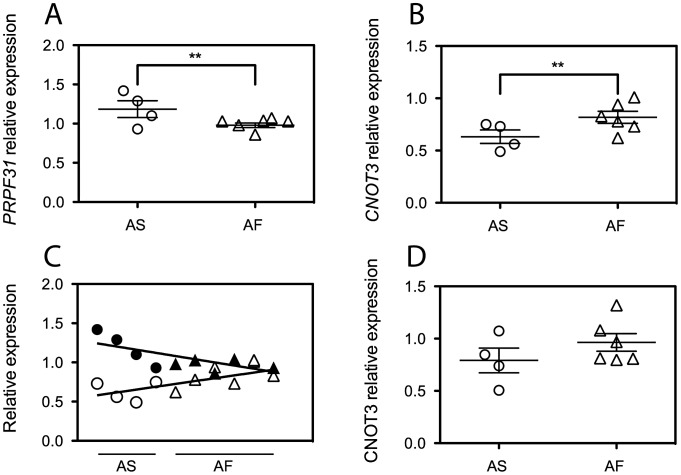

CNOT3 shows an opposite trend of expression with respect to that of PRPF31 between the asymptomatic (AS) and affected (AF) individuals of the AD5 family.(A) PRPF31 mRNA expression normalized to the housekeeping gene GAPDH. Error bars refer to the standard deviation of the mean for 5 independent experiments for each group. (B) CNOT3 mRNA expression from the same 5 experiments used to generate PRPF31 data. **, p<0.01. (C) Linear regression analysis of PRPF31 and CNOT3 mRNA expression, which shows an inverse trend of the two genes in each cell line. Circles, asymptomatic subjects; triangles, affected individuals; open symbols, CNOT3 expression; Filled symbols, PRPF31 expression. Data having the same value for the x axis have been obtained from the same individual. (D) Quantification of CNOT3 protein abundance relative to β-actin from 3 independent SDS-PAGE gels, after simultaneous detection of the two proteins by quantitative LI-COR western blot.